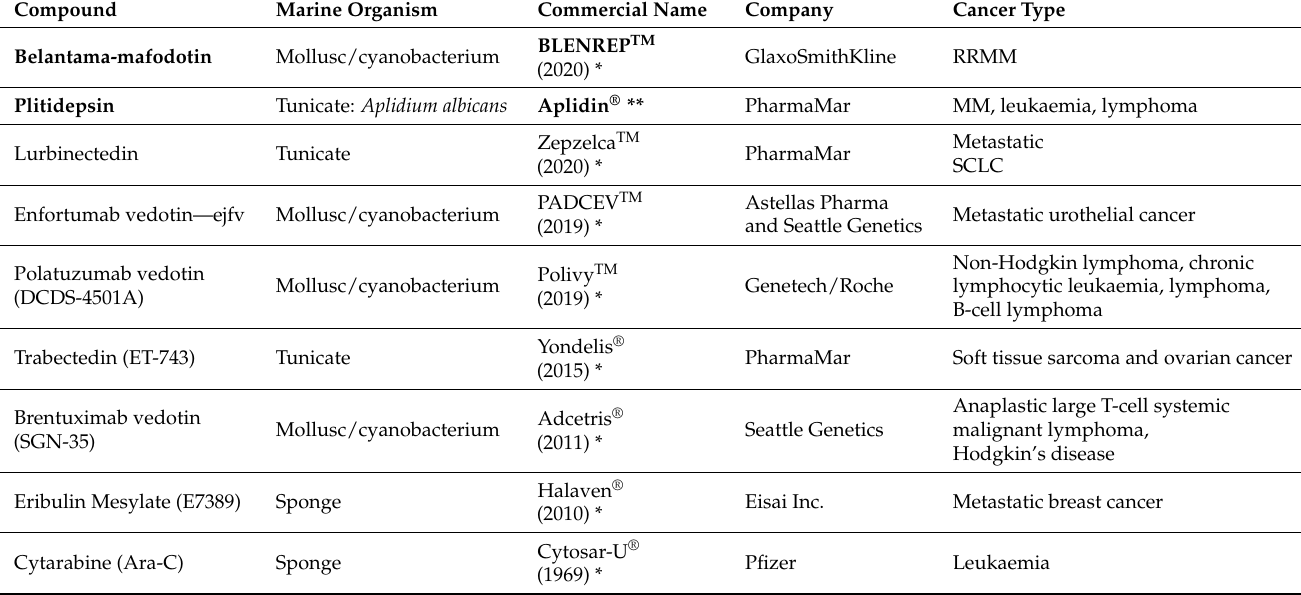
Table 1. Approved marine drugs for cancer therapy. Active ingredients are actively used to treat MM (in bold) or other cancer types. Derived marine organism, commercial name, manufacturing company, and cancer types are reported for each active ingredient. NSCLC, nonsmall-cell lung carcinoma; SCLC, small-cell lung carcinoma; MM, multiple myeloma; and RRMM, relapsed refractory multiple